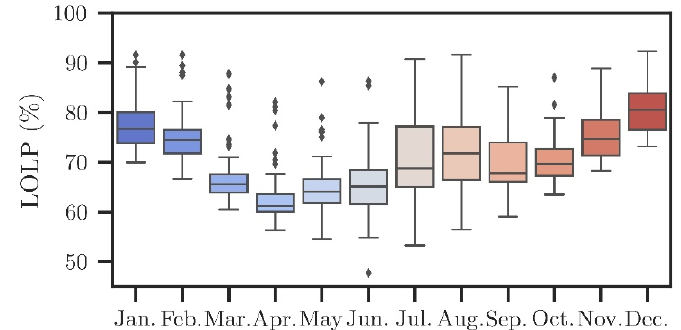
Figure 6. Monthly LOLP values of the analyzed households (n = 55).